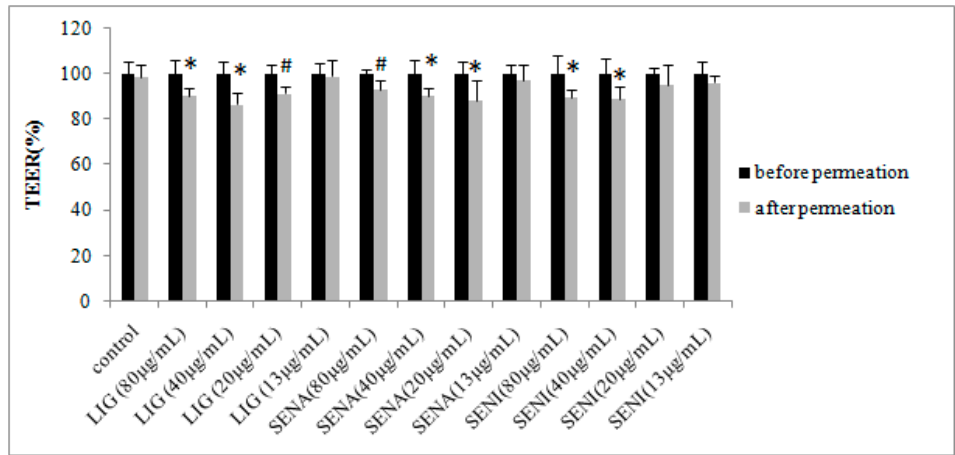
Figure 5. Transepithelial electrical resistance (TEER) before and after permeation of 400 µg/mL PF as control and in the presence of 400 µg/mL PF combined with LIG, SENI and SENA across MDCK-MDR1 monolayers. Data are expressed as mean ± SD ( n = 3). * p < 0.05 and # p < 0.01 compared with the value before permeation.